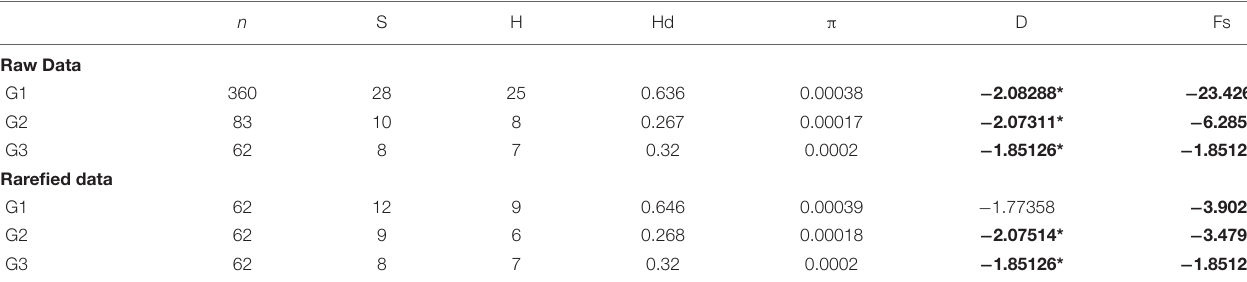
TABLE 4 | Genetic diversity within white-clawed crayfish SAMOVA groups in the Iberian Peninsula for the raw and rarefied data. n S H Hd π D